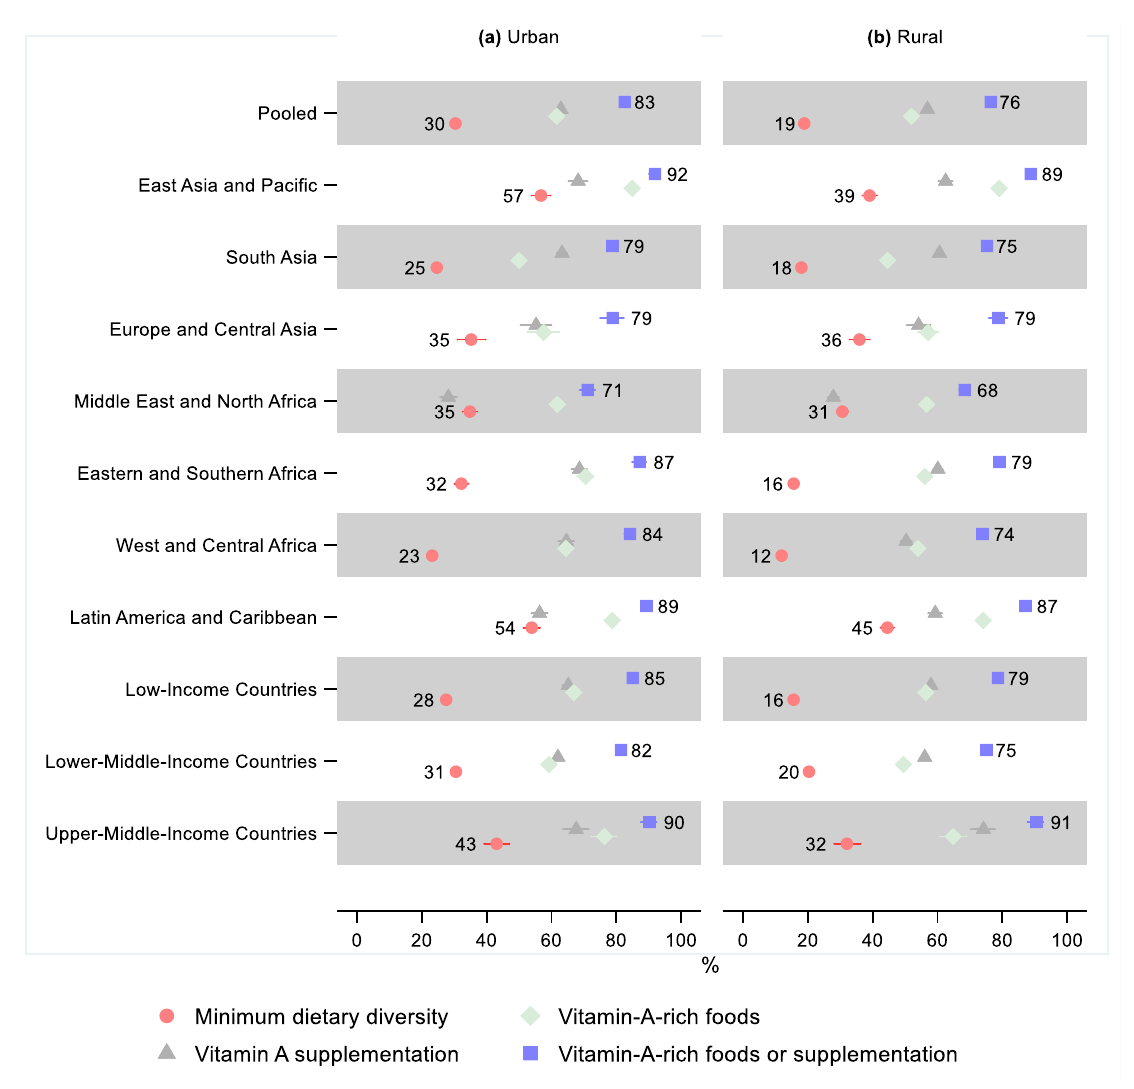
Figure 7. Percentage of children 6–23 months old that received the minimum dietary diversity, vitamin-A-rich foods, vitamin A supplementation, and either vitamin-A-rich foods or vitamin A supplementation in low- and middle-income countries by urban–rural residency. Notes: 95% confidence intervals are shown. Some confidence intervals may be narrower than the symbol for the estimate and therefore not visible. See Tables S13–S16 in the Supplement for the tabulated estimates and confidence intervals. See Figures S17–S20 in the Supplement for the plotted relative differences.